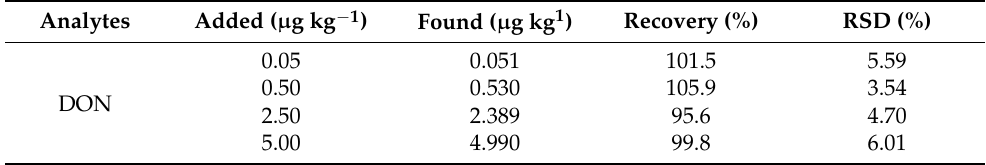
Table 2. DON recoveries in wheat samples analyzed by the proposed aptasensor platform (n =